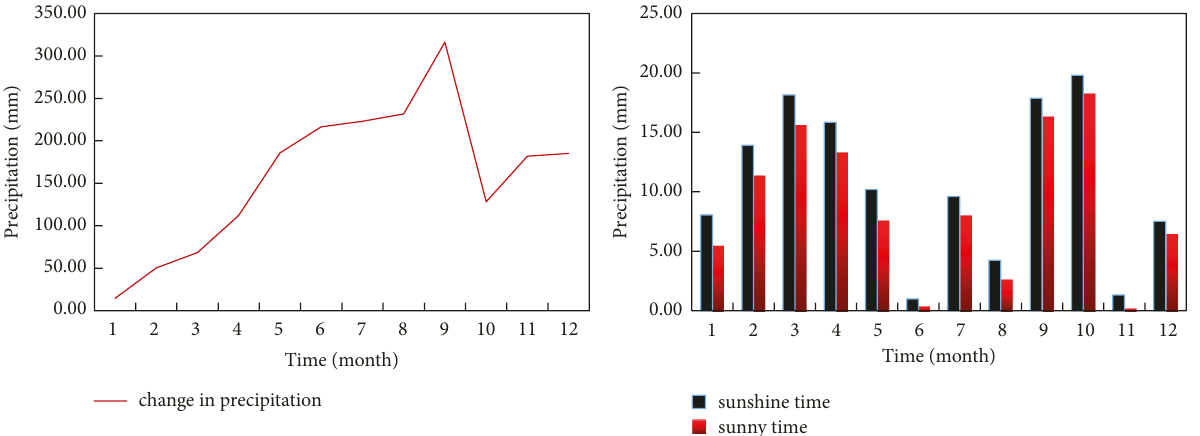
Figure 5: Changes in annual rainfall in village M.